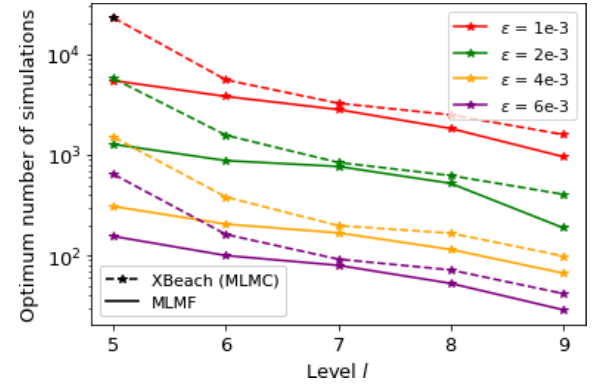
Figure 17. Optimum number of XBeach (HF) simulations required by MLMF (Eq. 14) and MLMC (Eq. B7) for the Carrier–Greenspan test case. The number required by MLMF is always substantially fewer than that required by MLMC.